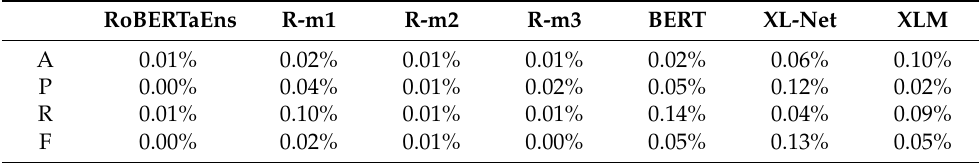
Table 5. Margin of Error comparison using 95%